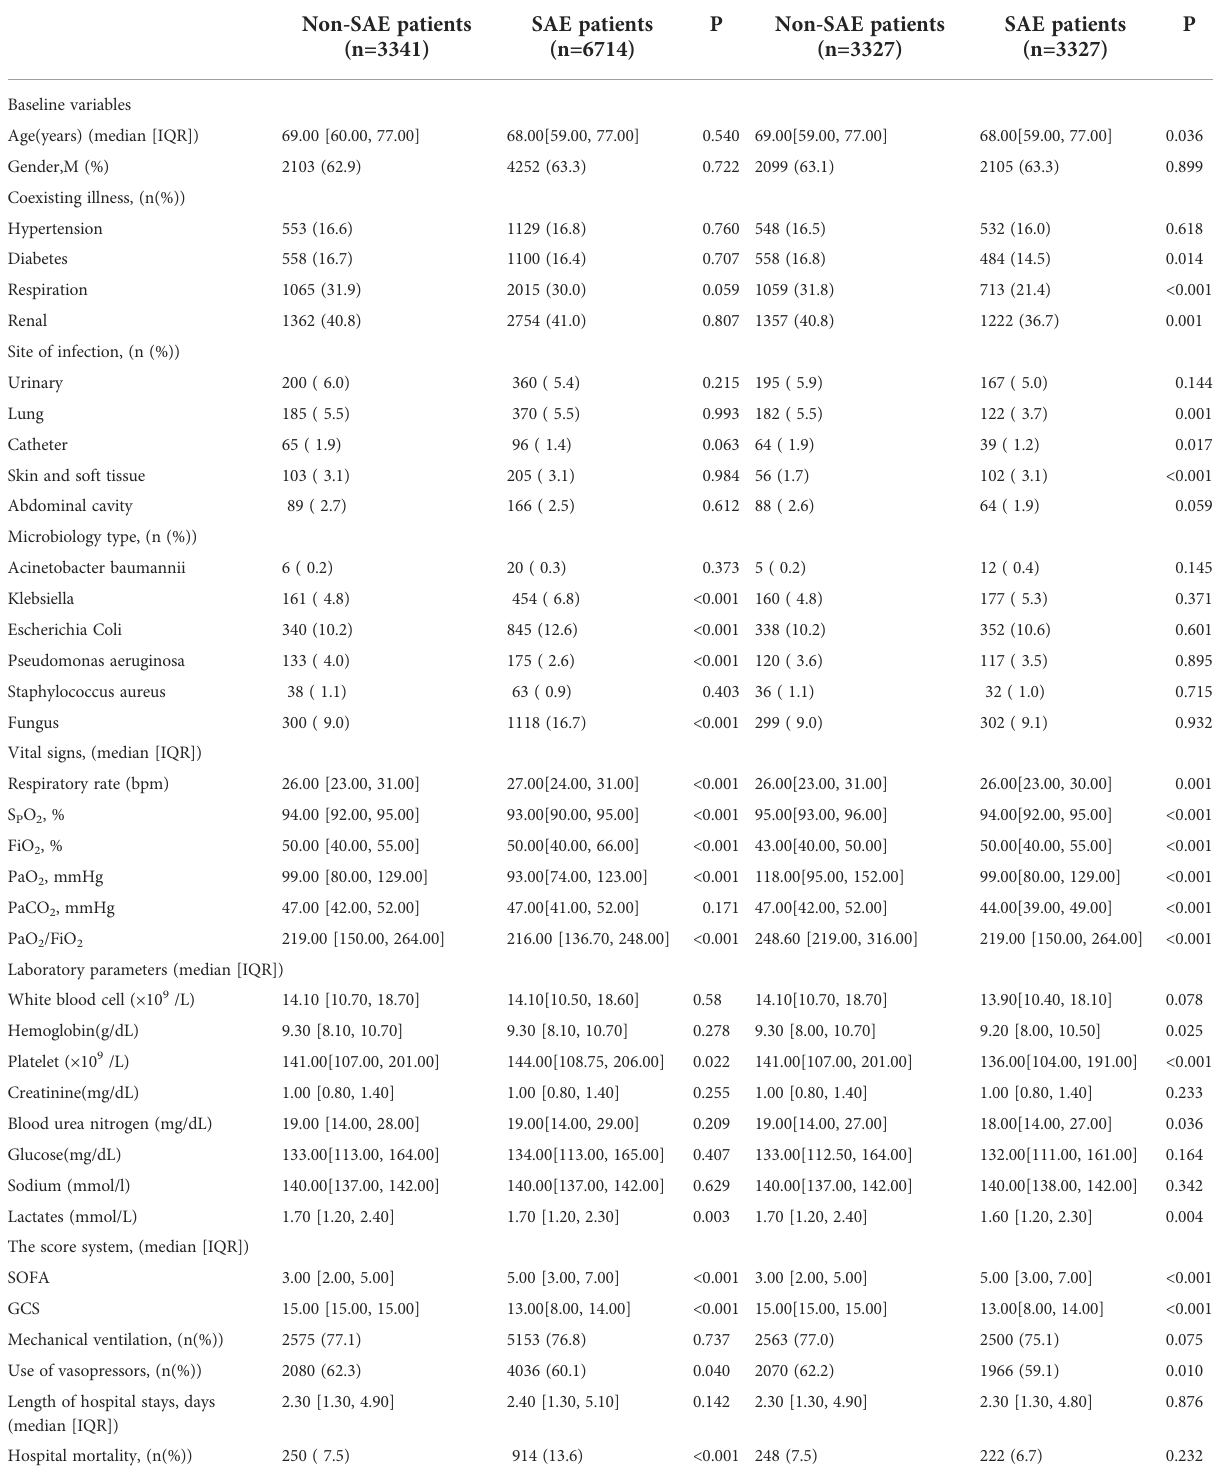
TABLE 1 Baseline characteristics and outcomes of sepsis